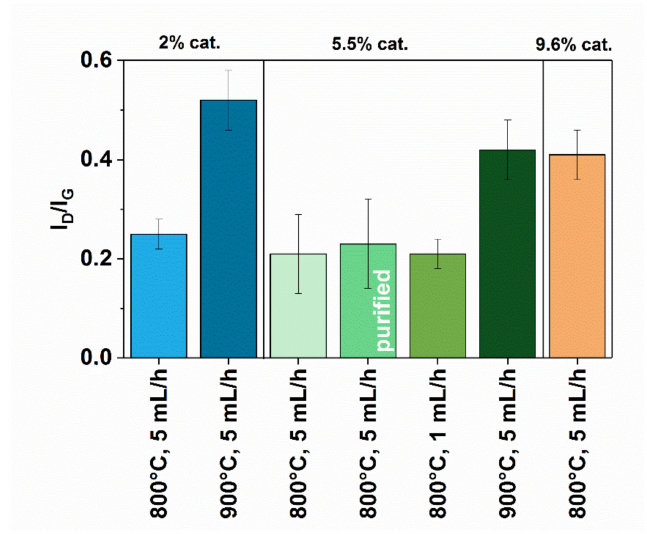
Figure 3. I D / I G values of MWCNTs as determined by Raman